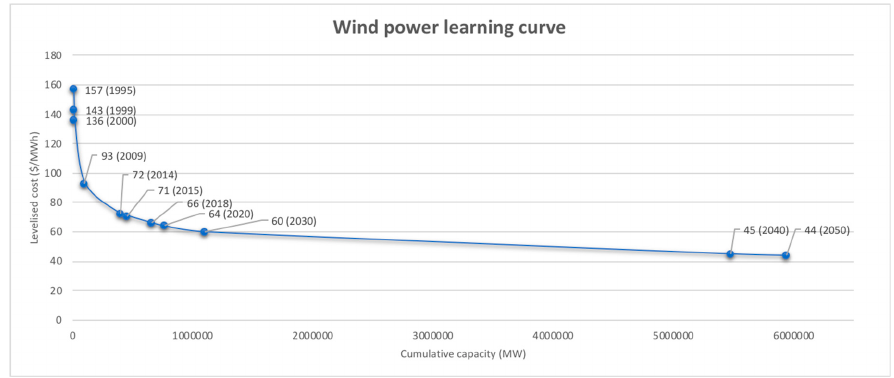
Figure 2. Wind power learning curve calculated from (1).